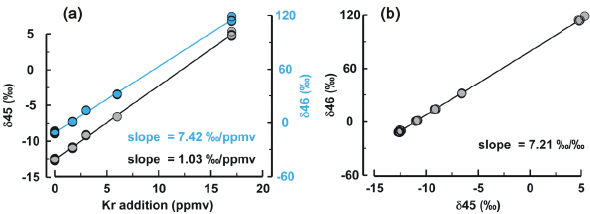
Fig. 13. Results of artificially adding pure Kr to a CH 4 sample. (a) Both isotope ratios show a linear relation of the δ values with the amount of Kr added. (b) The isotope ratios are closely corre- lated ( r 2 = 1 . 00) and this relation can be used to correct for the Kr interference without knowing the exact CH 4 -Kr mixing ratio of a sample. Note that here the δ 46/ δ 45 slope is shown, i.e. the inverse value used in Eq.